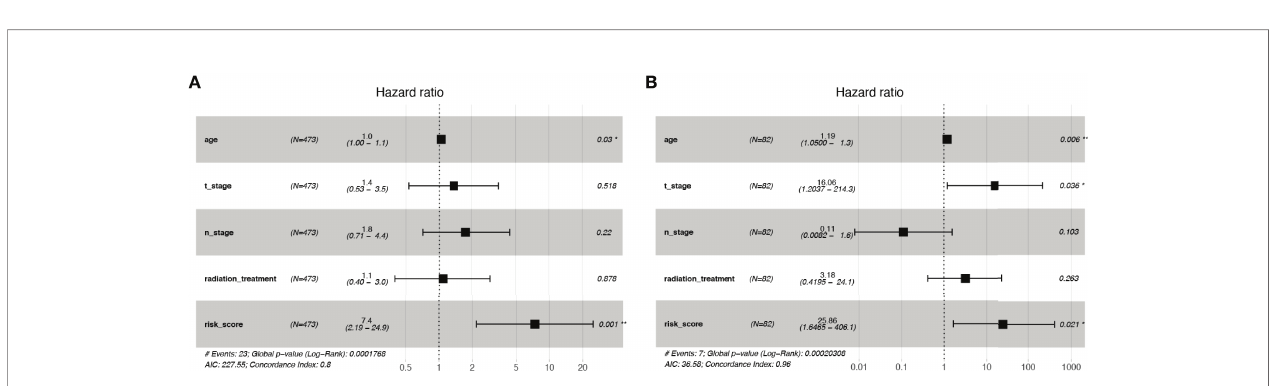
FIGURE 5 | Independence tests for risk scores. (A) Multivariate Cox regression risk forest plot in TCGA training cohort. (B) Multivariate Cox regression risk forest plot in SCHI validation cohort.